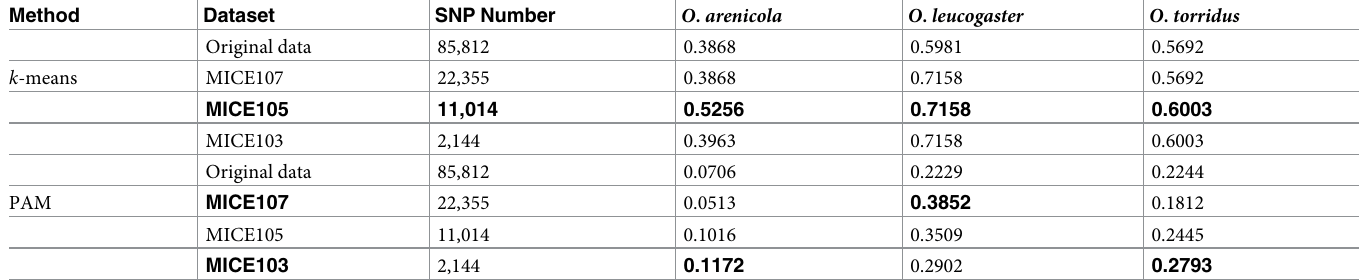
Table 3. The adjusted rand index (ARI) shows the agreement between the computed clusters using k -means clustering algorithm and partitioning around medoids (PAM) algorithm with k = 5, using the original grasshopper mouse SNP data set and the k -dominating subsets. ARI values listed below show the agreement measure- ment between original sample locations and clustering